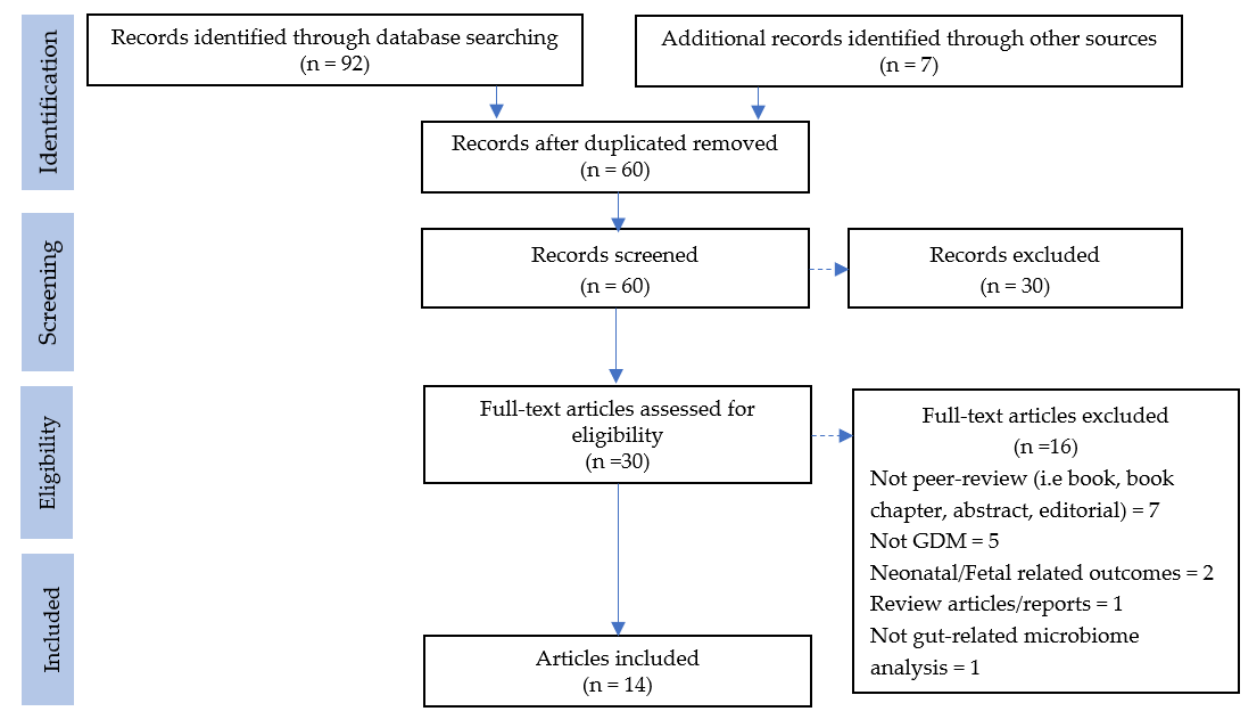
Figure 1. PRISMA flow chart of the article selection process. Table 1. Summary characteristics of included studies (n =